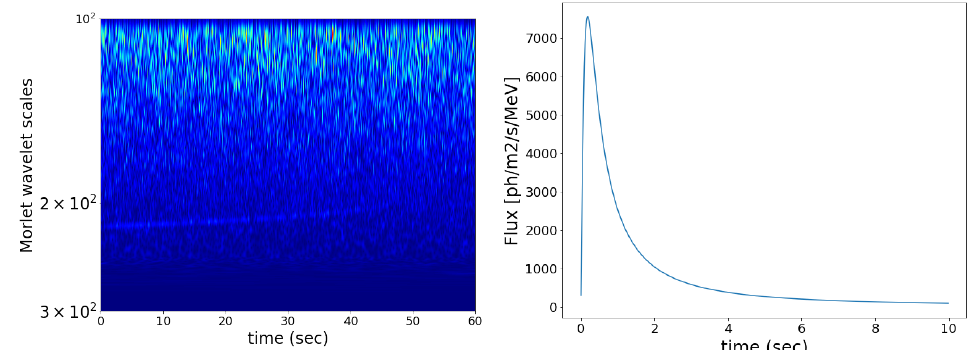
Figure 3. Sample binary neutron star with component masses 2.4 M (cid:12) and 1.8 M (cid:12) used as input to the ML model, at a distance of 283Mpc. The gravitational wave signal ( left ) and the GRB light curve ( right ) both contribute to the prediction. We turned off the x / y label (time-frequency information) to feed the CCN-2D network with